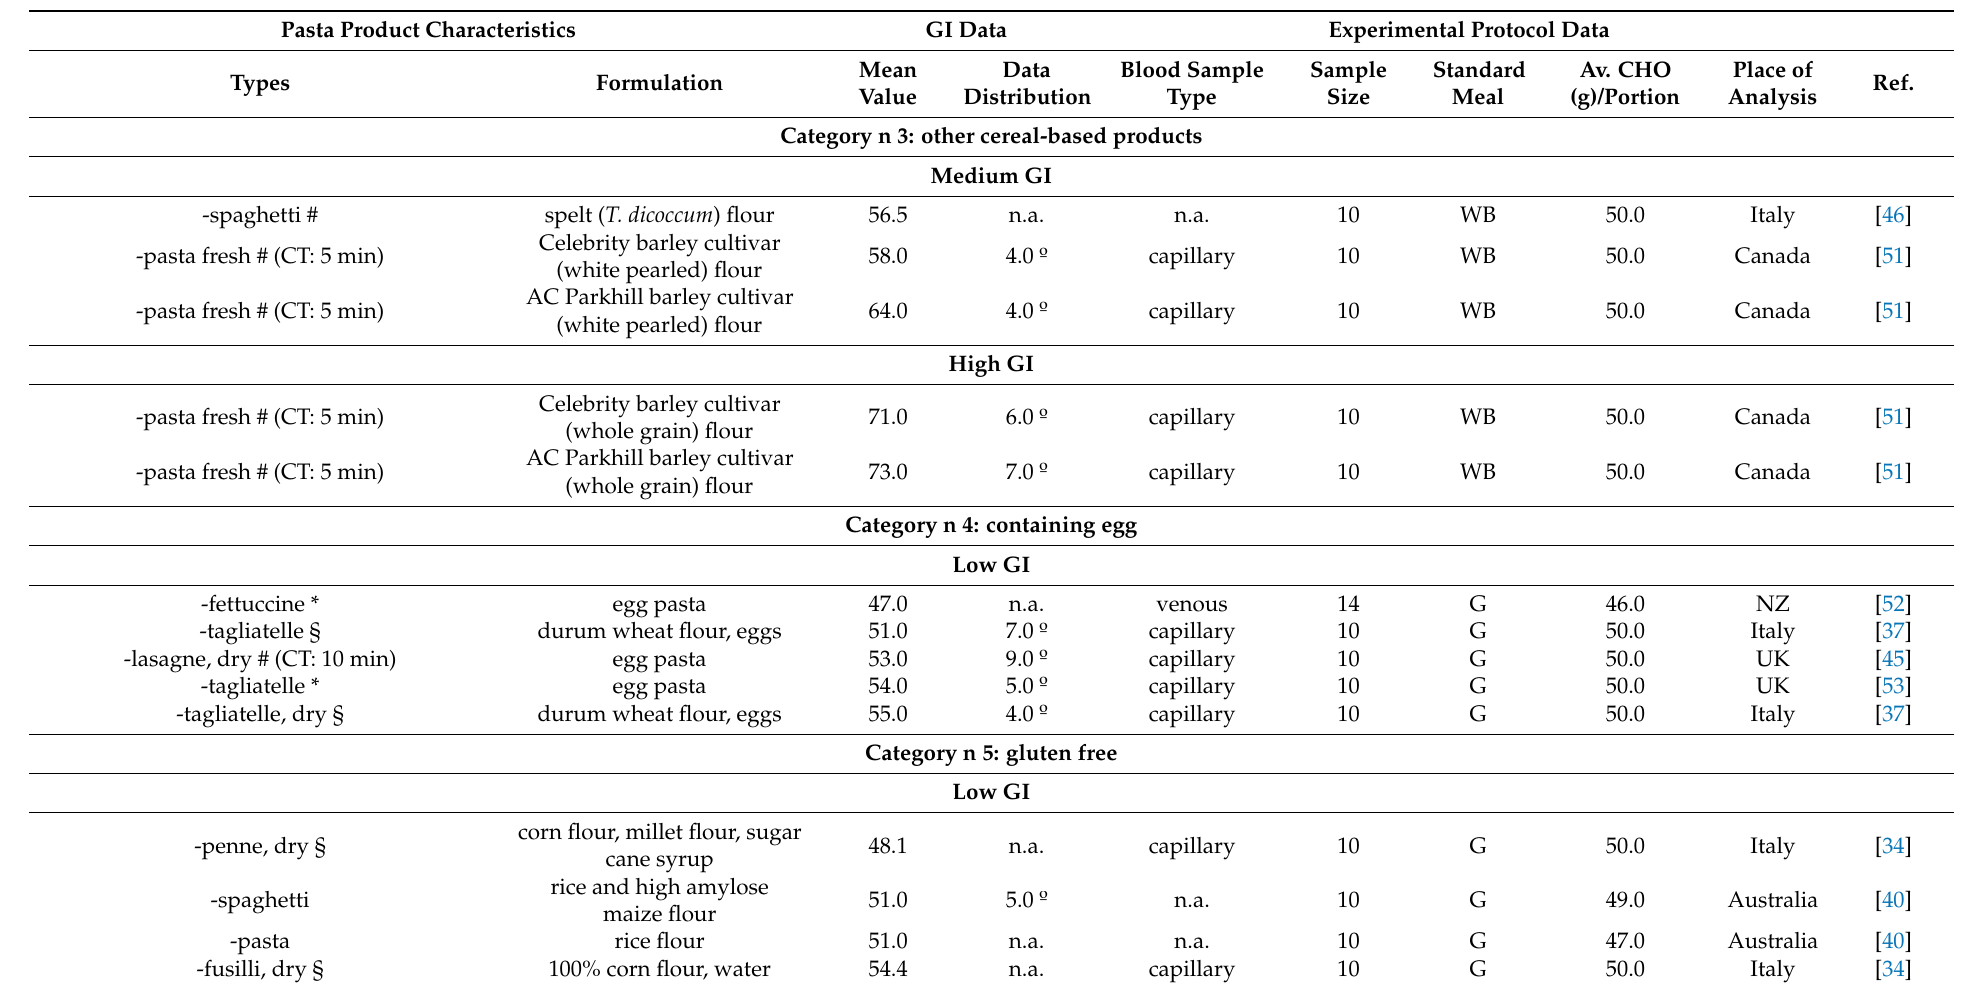
Table 1. Pasta product characteristics, glycemic index and experimental protocol data. Pasta Product Characteristics GI Data Experimental Protocol Data